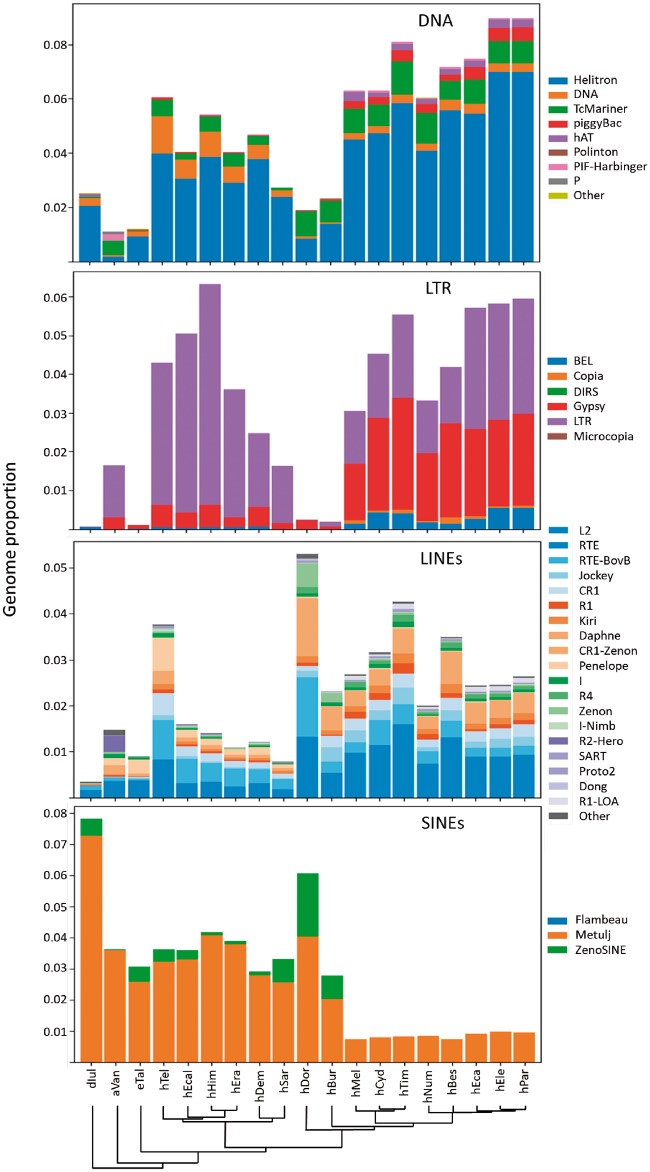
—Recent contributions to genome content from each of the four TE classes examined. Axes and abbreviations are as described in figure 2. Rolling circle (RC) transposons, Helitrons, are depicted as part of the DNA transposon plot.